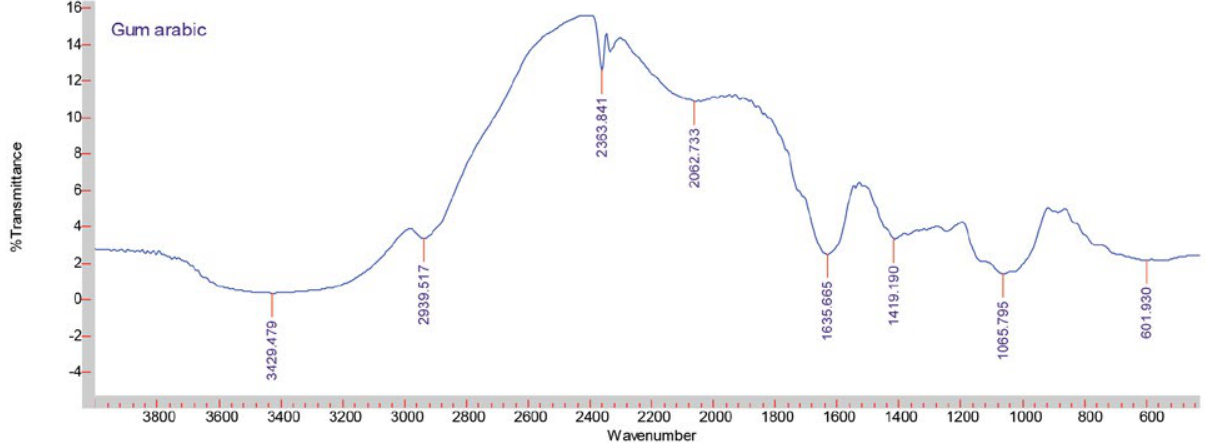
Figure 3. FT-IR spectrum of gum arabic